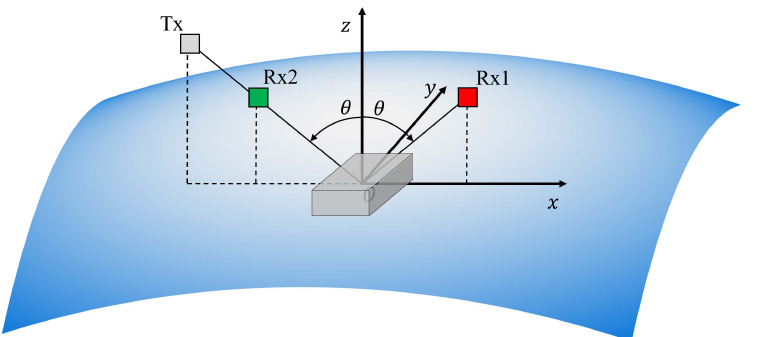
Figure 1. Conventional (LHCP-forward-scattering, red box) vs. unconventional (RHCP-backscattering, green box) GNSS-R.